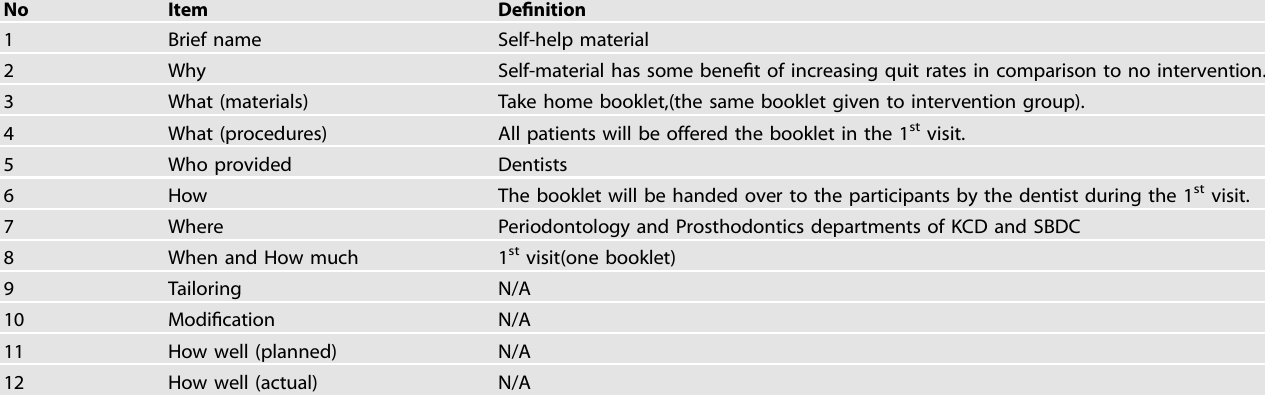
Table 2. TIDier Checklist-Self-help